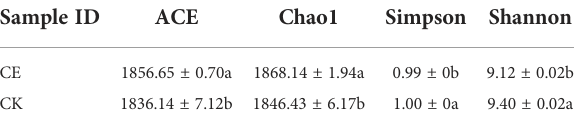
TABLE 2 Alpha – diversity of the rhizosphere soil of Maize. Sample ID